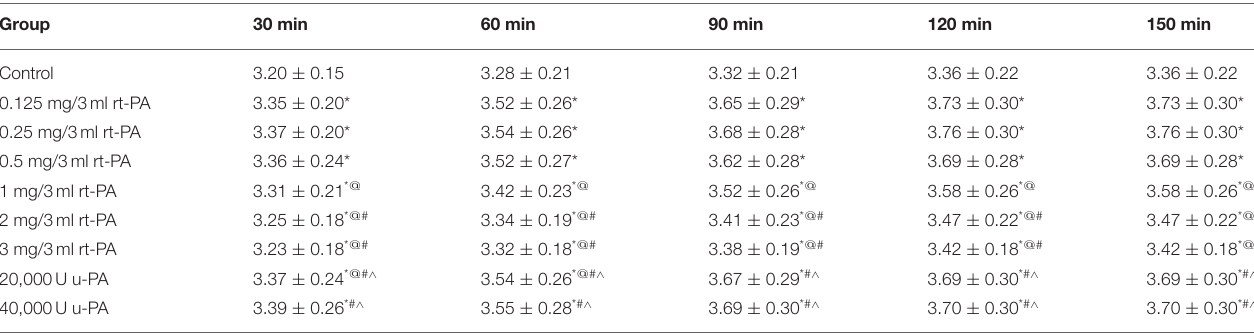
TABLE 3 | Effect of drugs concentration on the hemolytic